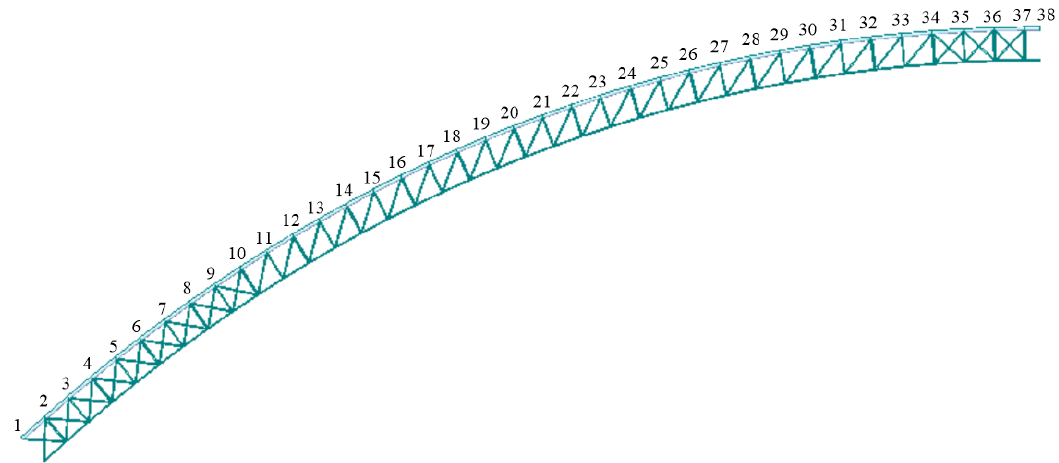
Figure 6. Vertical displacement monitoring position. Table 1. Vertical displacement of the cable tension stage.